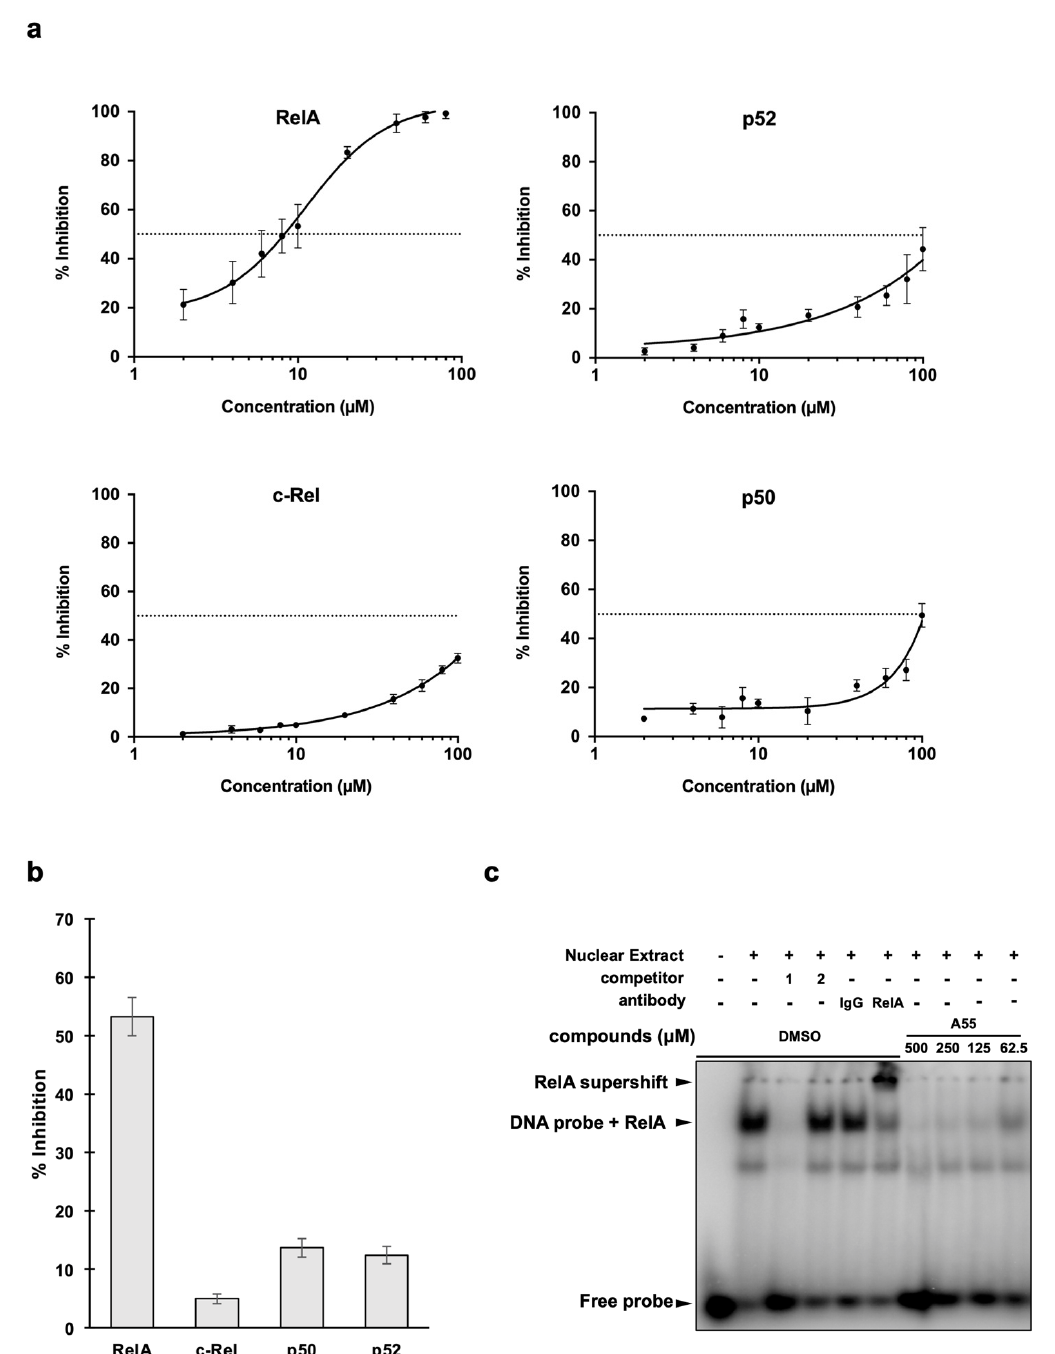
Figure 3. A55 is a RelA-specific inhibitor. ( a ) DSE-FRET inhibition rates of di ff erent concentrations of A55 against NF- κ B RelA, p52, cRel, and p50. ( b ) DSE-FRET inhibition rates of 10 µ M A55 against NF- κ B proteins. Error bars represent SD ( n = 3). ( c ) Electrophoretic mobility shift assay (EMSA) experiments with nuclear extracts from tumor necrosis factor (TNF)- α -treated PK8 cells were conducted using radiolabeled probes containing the NF- κ B binding site. Free probe only (lane 1), PK8 nuclear extracts (lane 2), competitor experiments (competitor 1 is nonlabeled NF- κ B probe (lane 3) and competitor 2 is nonlabeled sp1 probe (lane 4)), supershift experiments (rabbit IgG (lane 5) and rabbit RelA antibody (lane 6)), and di ff erent concentration of A55 (lanes